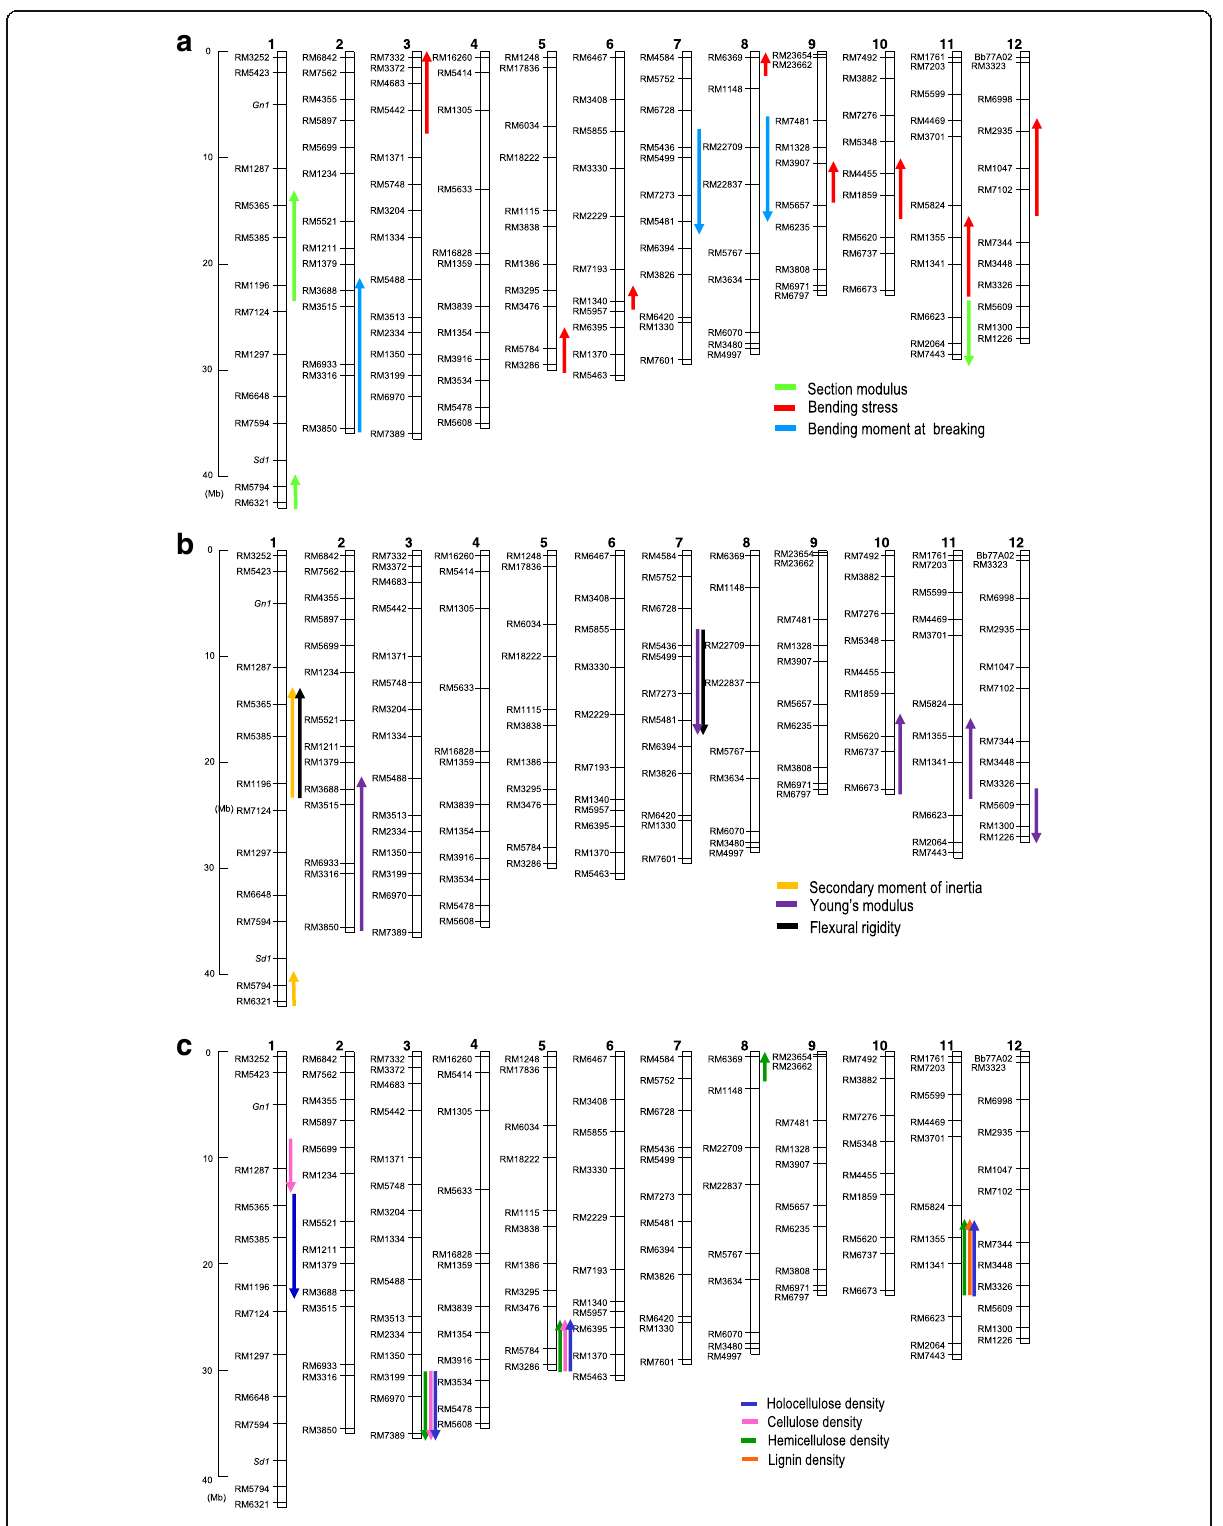
Fig. 4 Substitution mapping of QTLs by comparing overlapped segments among T-CSSLs. a breaking-type lodging resistance, b bending-type lodging resistance, and c cell wall materials densities. Upward arrows indicate positive effects, and downward arrows indicate negative